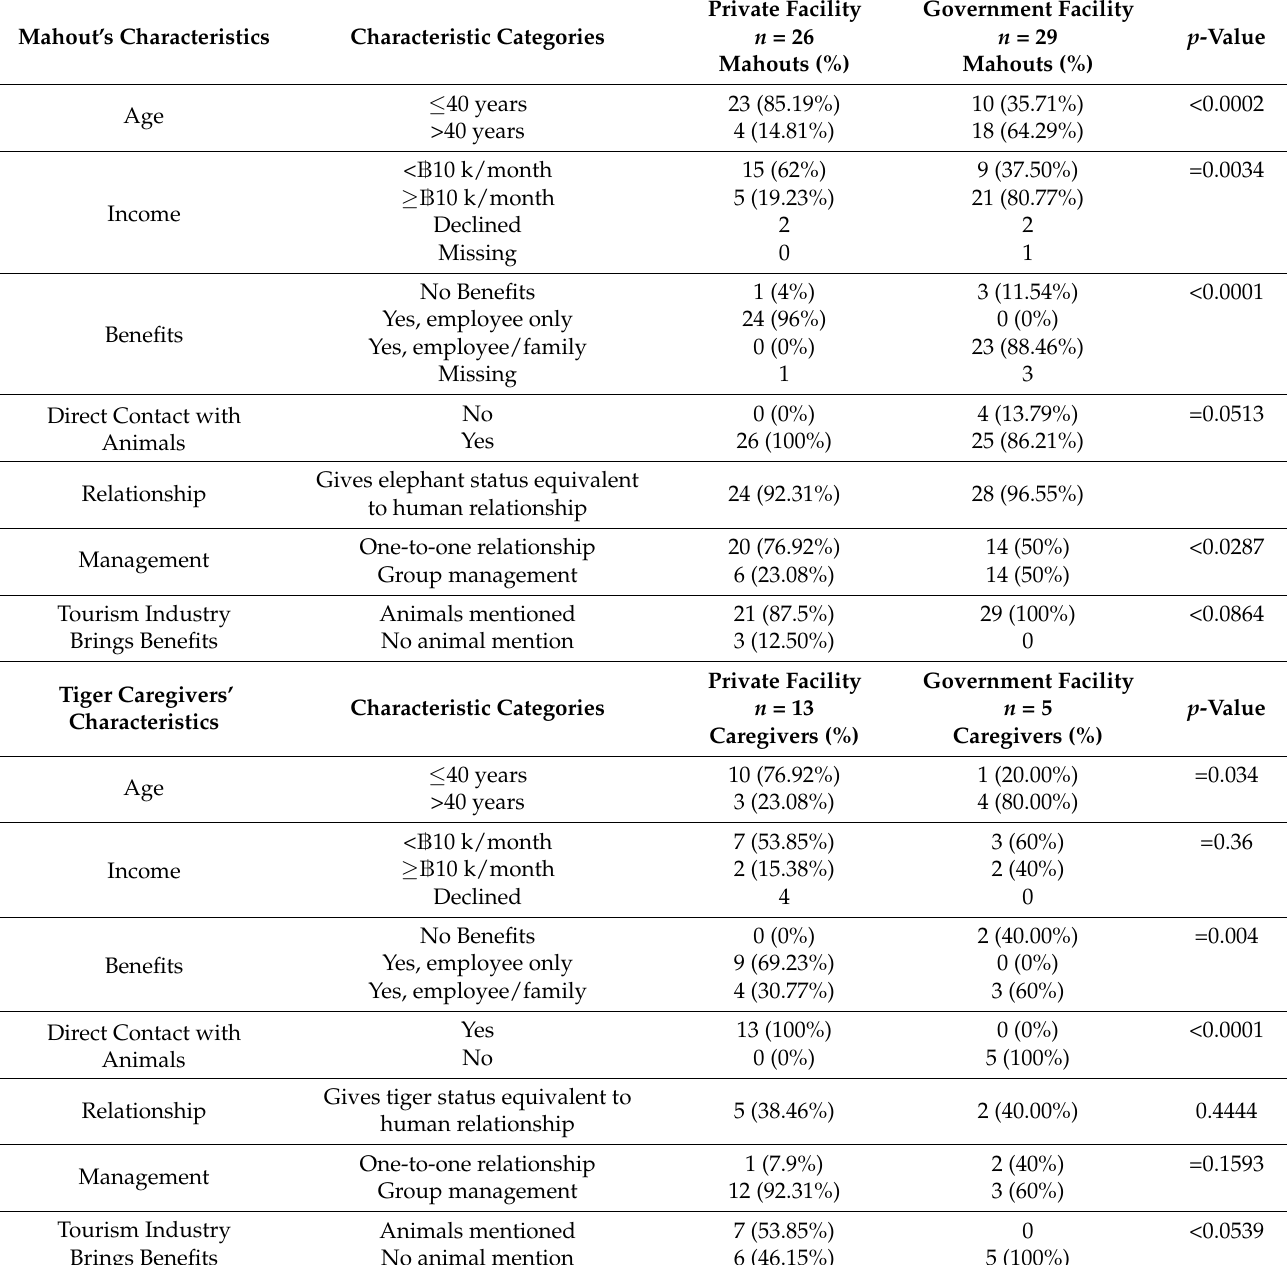
Table 2. Characteristics and perspectives of